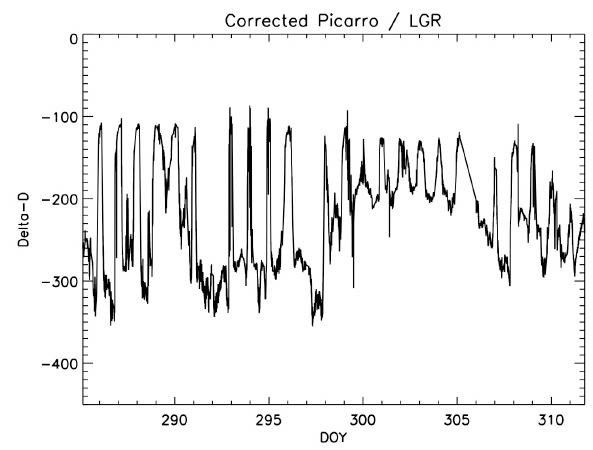
Fig. 1. Corrected time-series from an average of the Picarro/LGR data sets as described in Johnson et al. Figure 1: Corrected time-series from an average of the Picarro / LGR data sets as described in Johnson et al. (submitted)